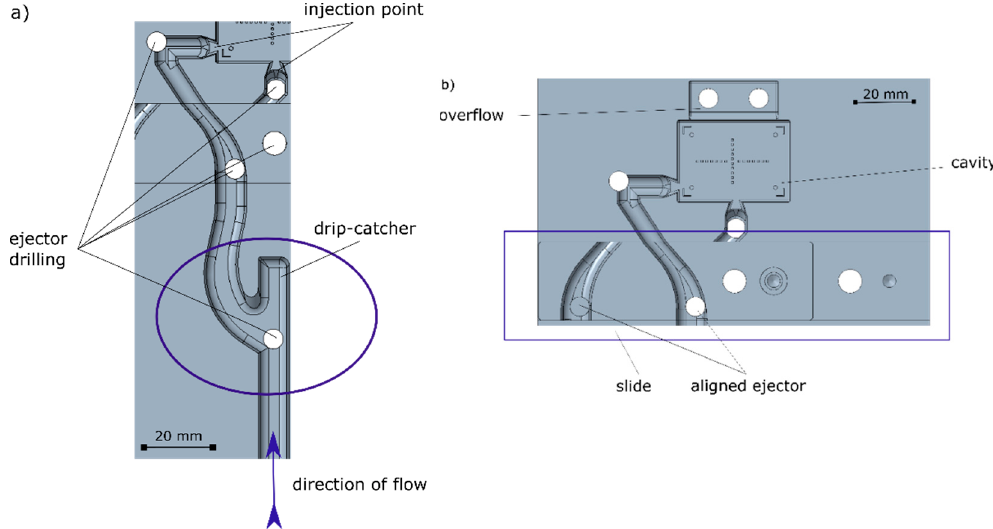
Figure 3. ( a ) sprue with plug interceptor. ( b ) sliding feed for selection of the direction of injection with point of injection from the left (longitudinal to the mirror surface) and from the center (orthogonal to the mirror surface).